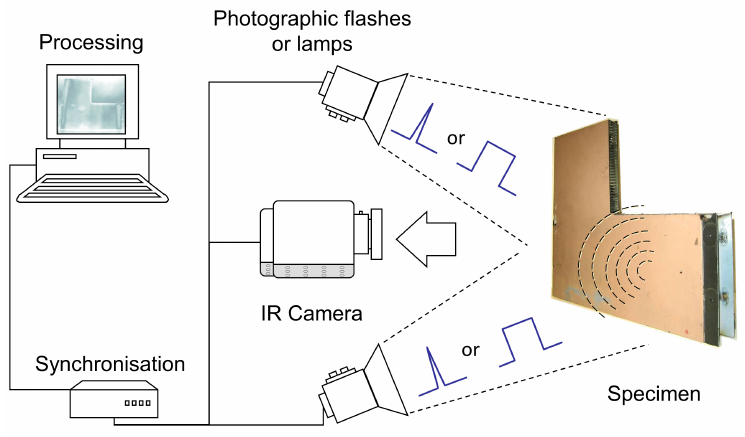
Figure 6. Schematic view of a pulsed thermography inspection, modified with permission from MiViM. 1: Flash lamps, 2: specimen, 3; camera, 4: processing